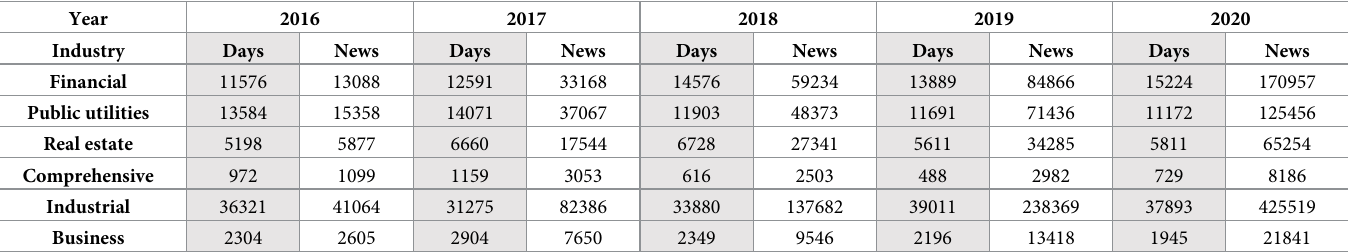
Table 2. Experimental data distribution.